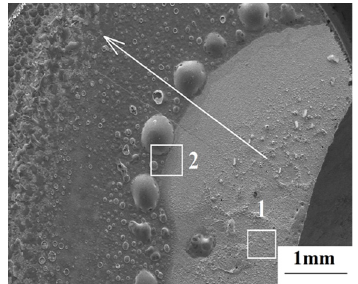
Figure 3. The surface macrostructure of the sample after ablation for 20 s.